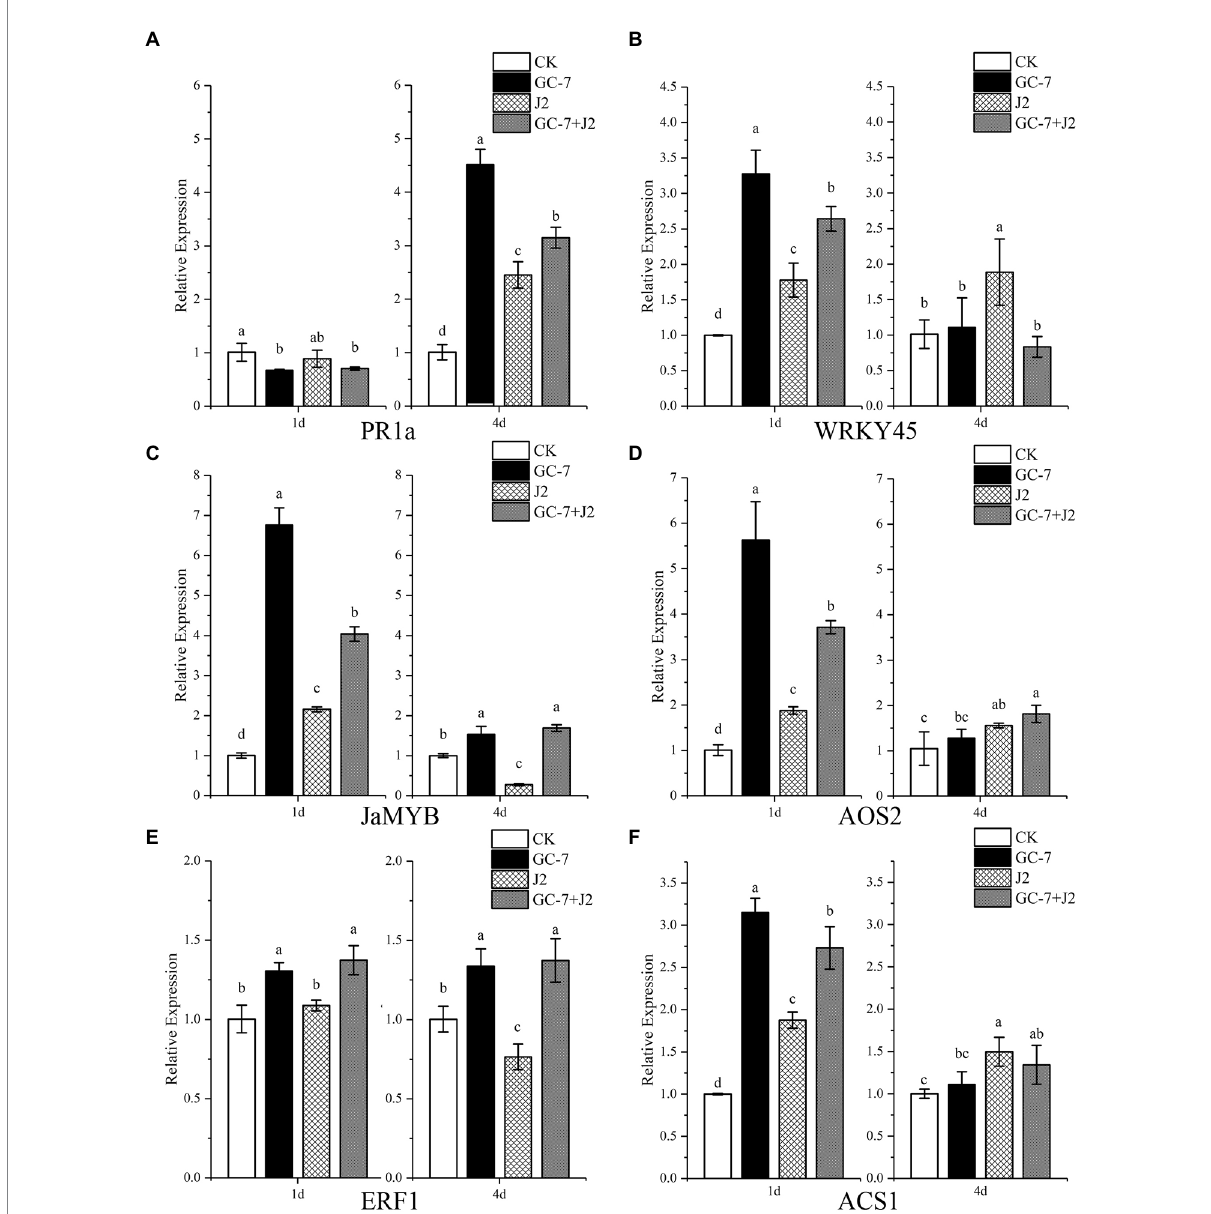
FIGURE 7 Quantitative RT-PCR analysis of genes involved in the salicylic acid, jasmonic acid, and ethylene pathways in rice roots. (A) Relative expression of PR1a . (B) Relative expression of WRKY45 . (C) Relative expression of JaMYB . (D) Relative expression of AOS2 . (E) Relative expression of ERF1 . (F) Relative expression of ACS1. Gene expression levels were analyzed from four treatments: CK, GC-7, J2, GC-7 + J2 at 1 and 4 days after M. graminicola infection. Each pot contains five two-leaf stage rice seedings and was drenched with 40 ml of 50% GC-7 (1 × 10 9 cfu/ml) or sterilized water. The individual pot was inoculated with approximately 1,500 freshly hatched M. graminicola J2s 2 days later. Rice seedlings were treated with sterile water as the non-treated control Error bars represent standard error of the mean values of three independent replicates from four biological replicates. All treatments are significantly different from each other at p < 0.05. For each gene and time point, bars with different letters indicate statistically significant differences between